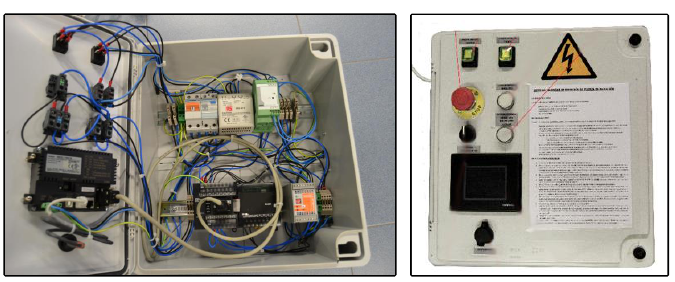
Figure 3. Final aspect of